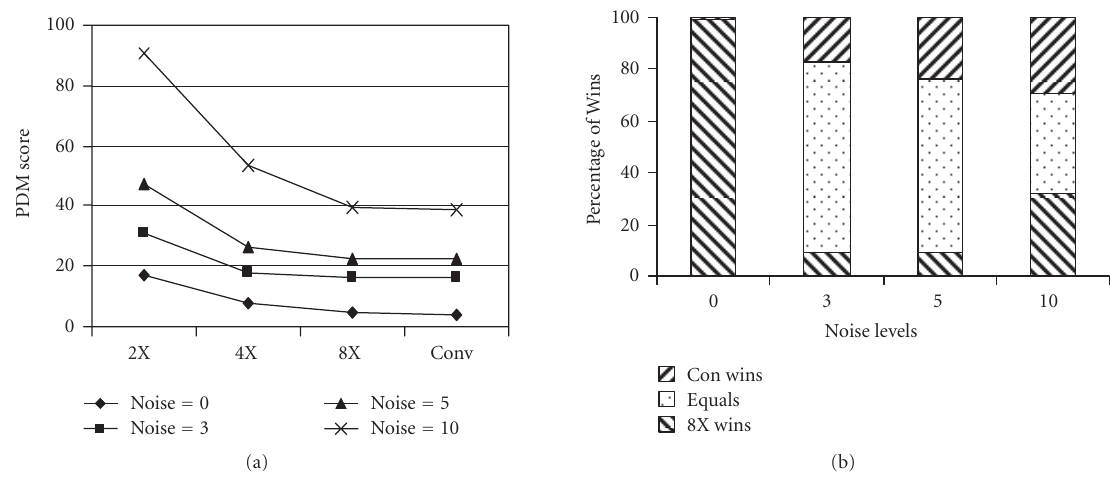
Figure 8: The comparison of regridding methods. The average performance of four regridding methods under di ff erent noise conditions is shown in (a). Conventional regridding and MXR 8X show obvious advantages over MXR 2X and MXR 4X. Conventional regridding and MXR 8X are compared case by case in same conditions and the statistical results are shown in (b). For noise conditions, we have tested 100 realizations for each image, and the PDM scores are statistically analyzed. In (b), the “equals” are only applied in the meaning of statistic ( t test with 0 . 95 confidence interval) and do not apply to noise-free condition.